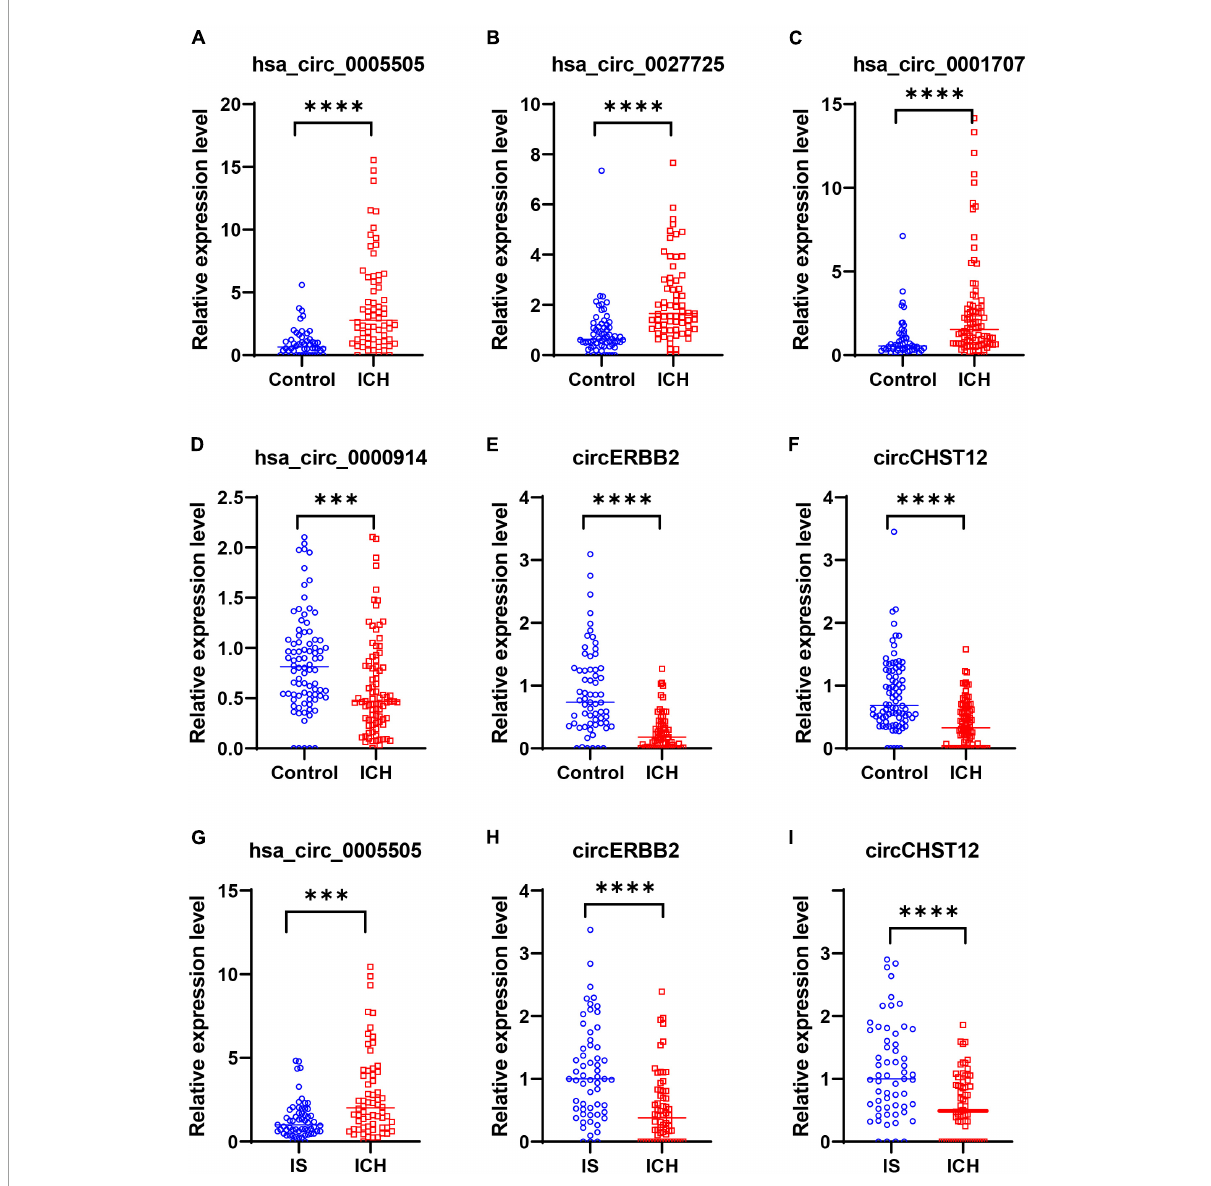
FIGURE5 Validation of circRNA expression levels by quantitative real-time polymerase chain reaction (RT–qPCR). (A–F) RT–qPCR results validated the expression levels of candidate circRNAs in all samples between 64 intracerebral hemorrhage (ICH) patients and 50 healthy controls. (A) hsa_circ_0005505, (B) hsa_circ_0027725, (C) hsa_circ_0001707, (D) hsa_circ_0000914, (E) circERBB2 and (F) circCHST12. (G–I) RT–qPCR results validated the expression levels of hsa_circ_0005505 (G) , circERBB2 (H) and circCHST12 (I) between 64 ICH patients and 59 ischemic stroke (IS) patients. The data are presented as the median (interquartile range). ∗∗∗ p < 0.001, ∗∗∗∗ p < 0.0001. Statistical significance was assessed using the Mann–Whitney U